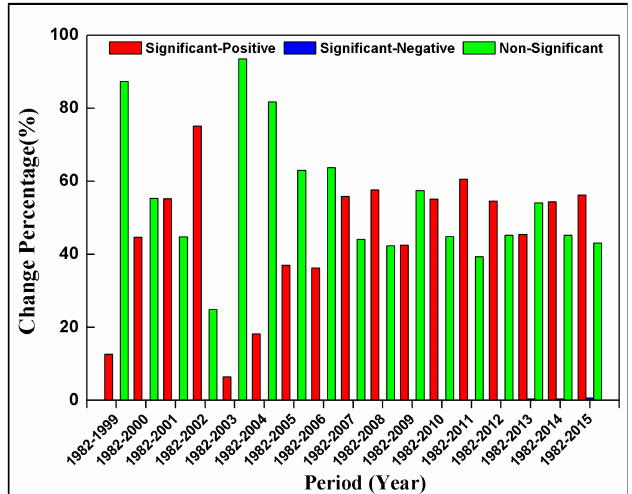
Figure 5. Area fraction of the AGG displaying different statistical significance levels with progressively longer time series since 1982 (%). Significant positive stands for the increasing of GPP and significant negative refers to the reduction of GPP; both indicate a statistical significance of the linear regression with a Pearson correlation less than